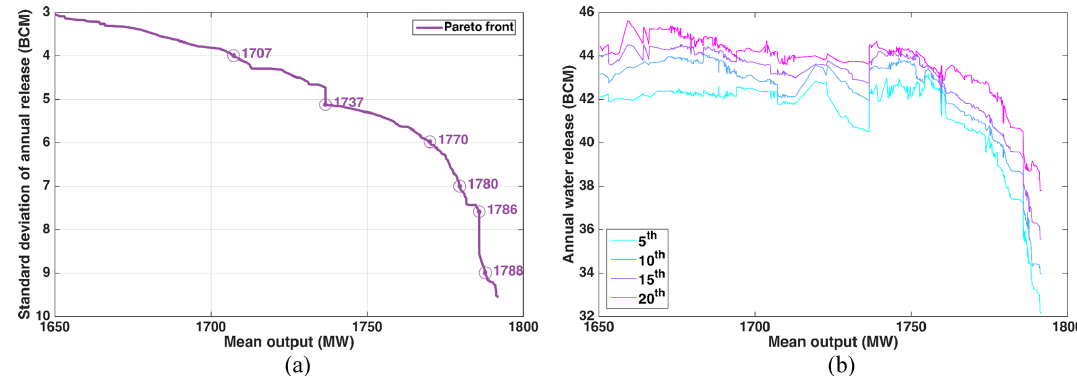
Figure 5. Multi-objective optimization results of reservoir operating rules in terms of (a) Pareto front and (b) the relationship between power generation and the 5th, 10th, 15th, and 20th percentile of annual water